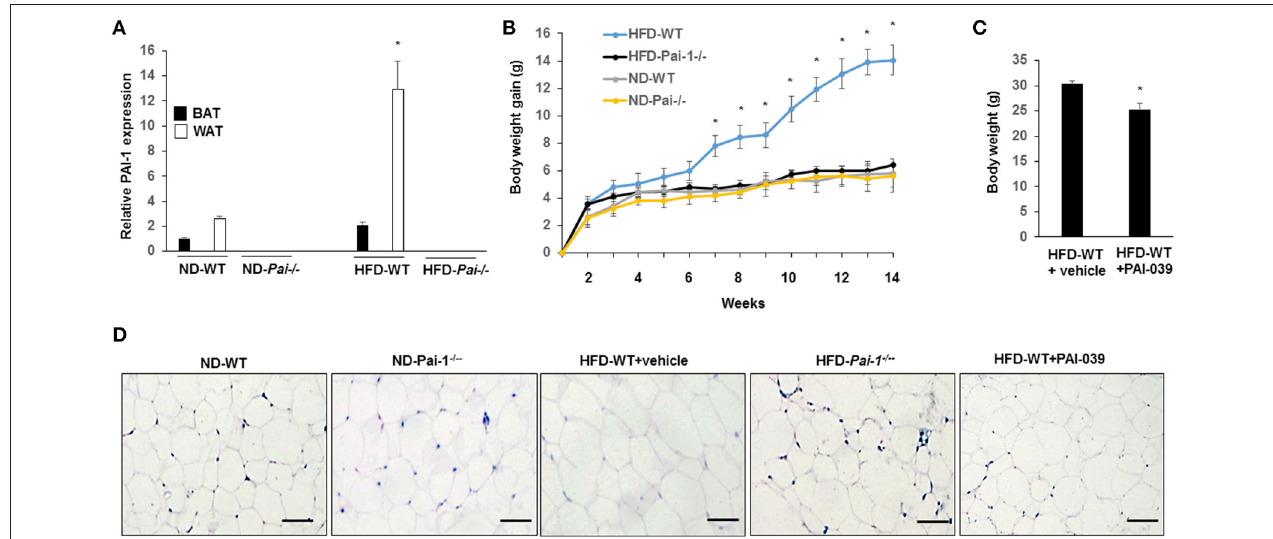
FIGURE 1 | Genetic deletion and pharmacological inhibition of PAI-1 protects from HFD-Induced Weight Gain and associated metabolic disturbances. (A) Expression level of PAI-1 in brown adipose tissue (BAT) and white adipose tissue (WT) of normal chow diet-fed WT (ND-WT), ND- Pai-1 − / − , high fat chow-fed WT (HFD-WT), and HFD- Pai-1 − / − mice. * P < 0.05 vs. ND-WT. (B) Changes in body weight of male Pai-1 − / − ( n = 9) and their littermate controls (WT, n = 13) after being fed an HFD for Pai-1 − / − 14 weeks. Initial body weights were 23.6 ± 0.16g for WT and 18.2 ± 0.78g for Pai-1 − / − mice. * P < 0.05 vs. HFD- Pai-1 − / − mice. (C) Body weight was assessed by PAI-039 treatment after 30 days in HFD-WT mice. * P < 0.05 vs. vehicle. (D) Representative histological images of epididymal white adipose tissue (eWAT) of ND-WT, ND- Pai-1 − / − , HFD-WT, and HFD- Pai-1 − / − mice.